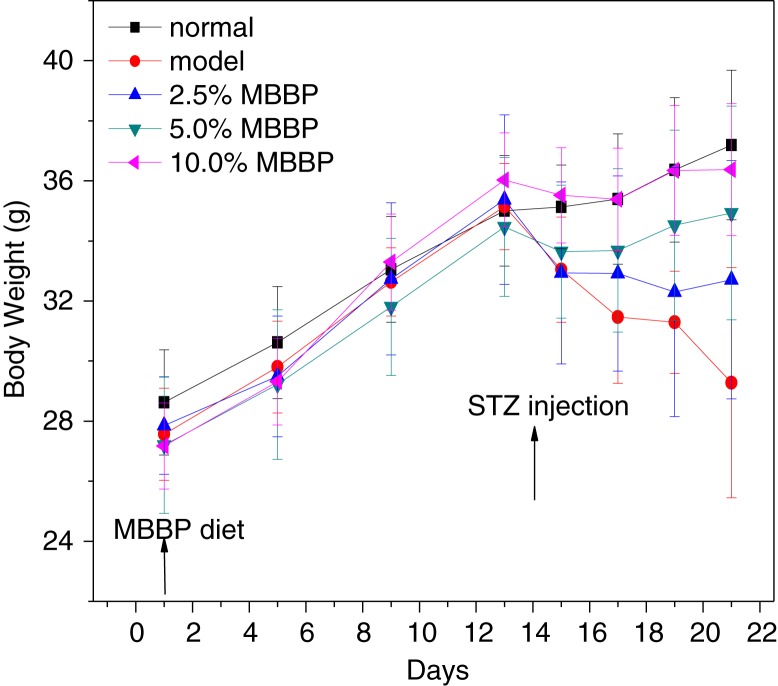
The effect of MBBP on the body weight of mice. Normal mice (no STZ injection) and model groups with STZ injection were fed with standard diet. Three MBBP-treated mice with STZ injection were administrated with standard diets containing 2.5, 5.0, and 10.0% MBBP, respectively. Data are mean ±SE values of 10 mice.